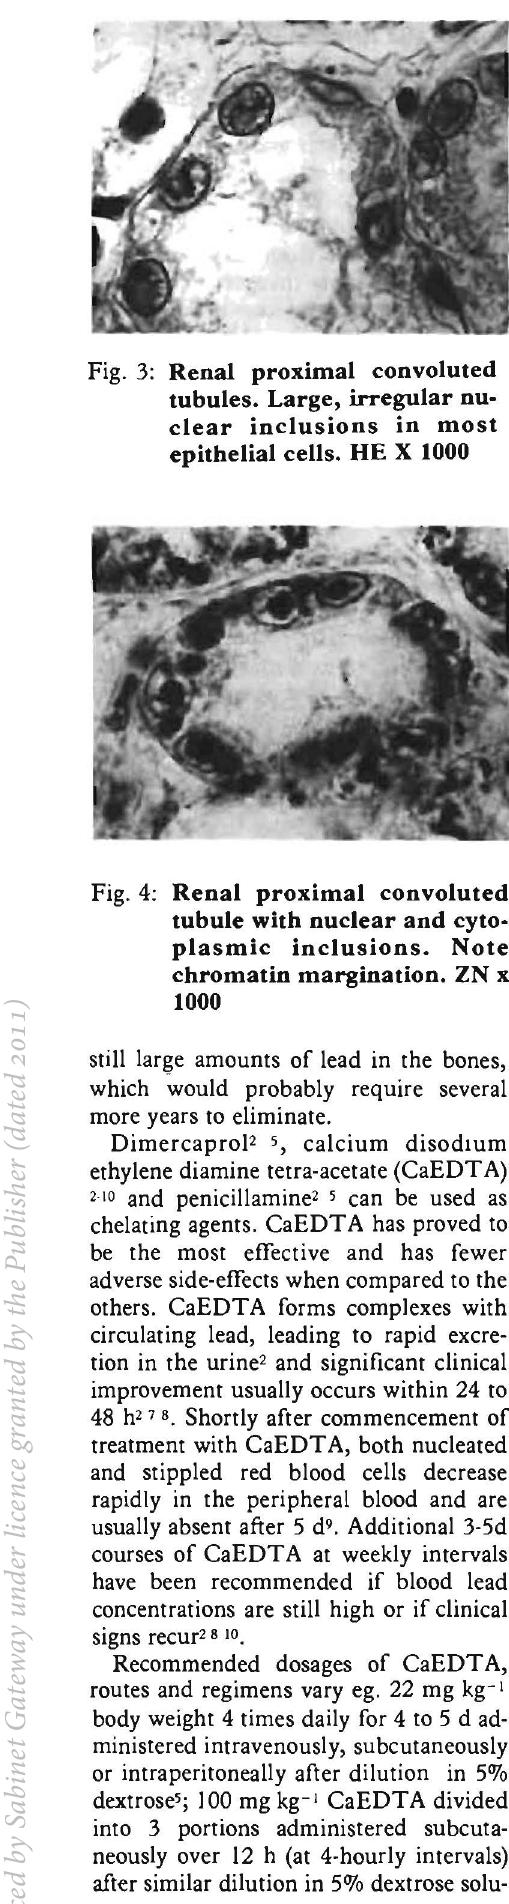
Fig. 3: Renal proximal convoluted tubules. Large, irregular nu clear inclusions in most epithelial cells. HE X 1000